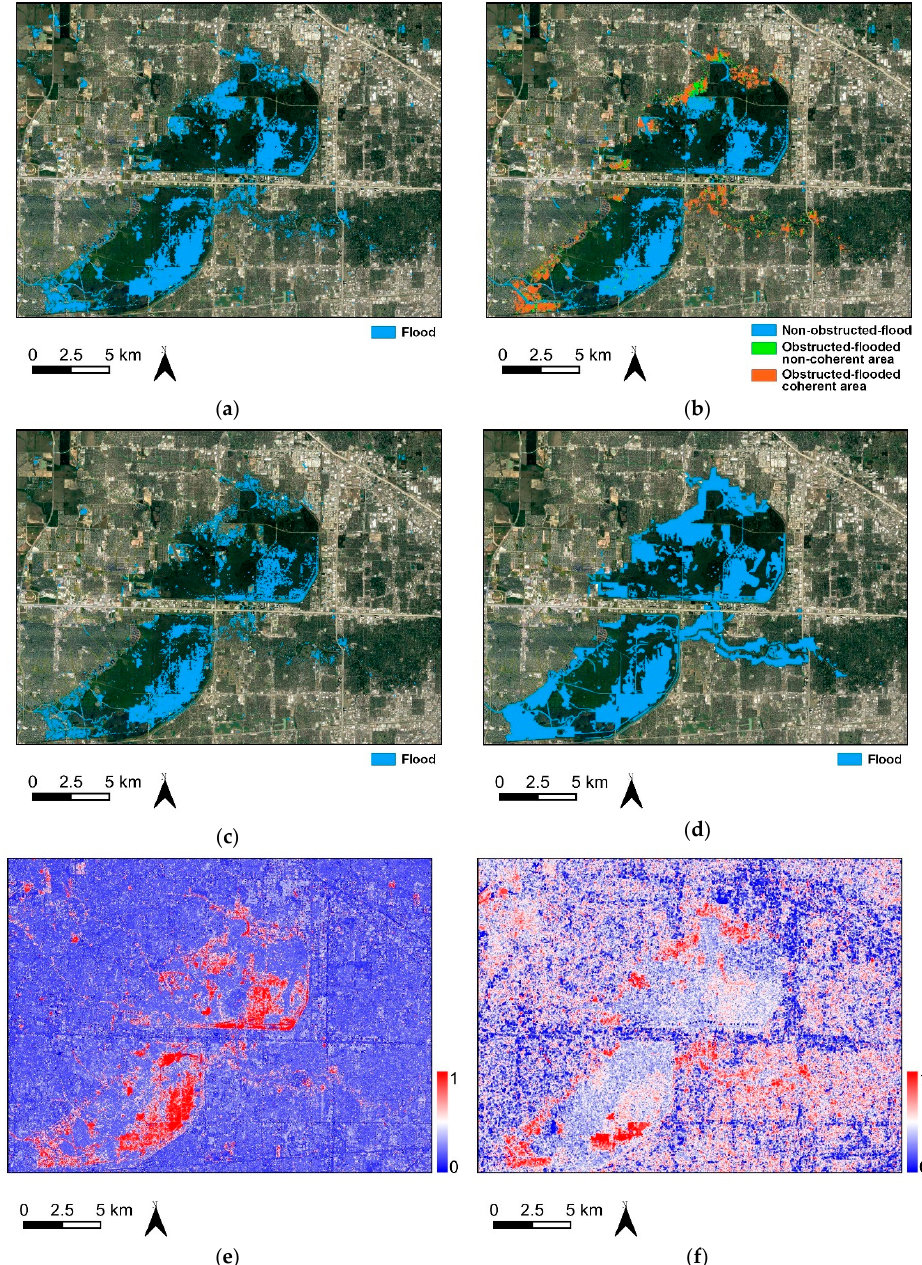
Figure 3. Flood extent maps of the Houston study area: ( a ) Binary flood extent based on the fusion of σ ° and γ ; ( b ) Flood category map of ( a ); ( c ) Binary flood extent based on σ ° alone; ( d ) Reference flood mask derived from high-resolution aerial photographs provided by the National Oceanic and Atmospheric Administration (NOAA); ( e ) Flood posterior probability conditioned on σ °; ( f ) Flood posterior probability conditioned on γ .